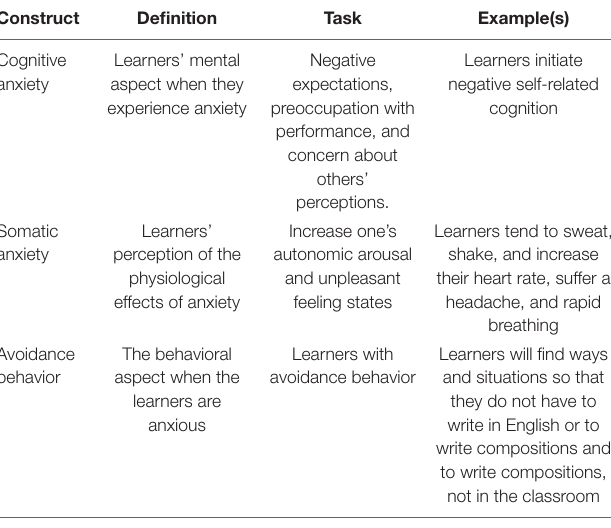
TABLE 2 | Dimensions and general issues of epistemic beliefs